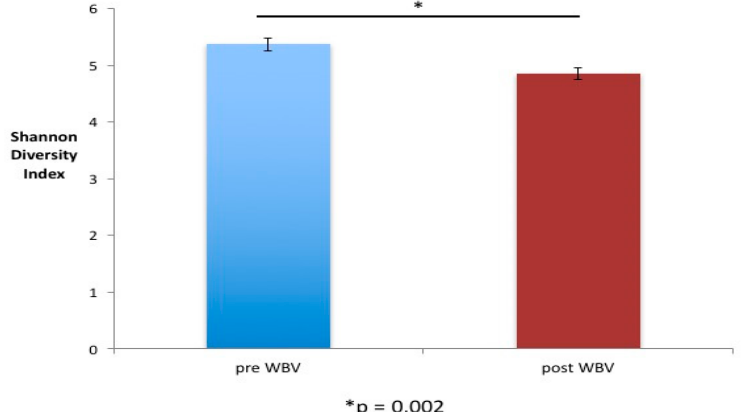
Figure 4. Alpha diversity changed with WBV. There was a significant decrease in gut microbial diversity (Shannon Diversity Index) between pre- and post-WBV samples (Error bars = standard error). * Statistically significant difference between two groups.